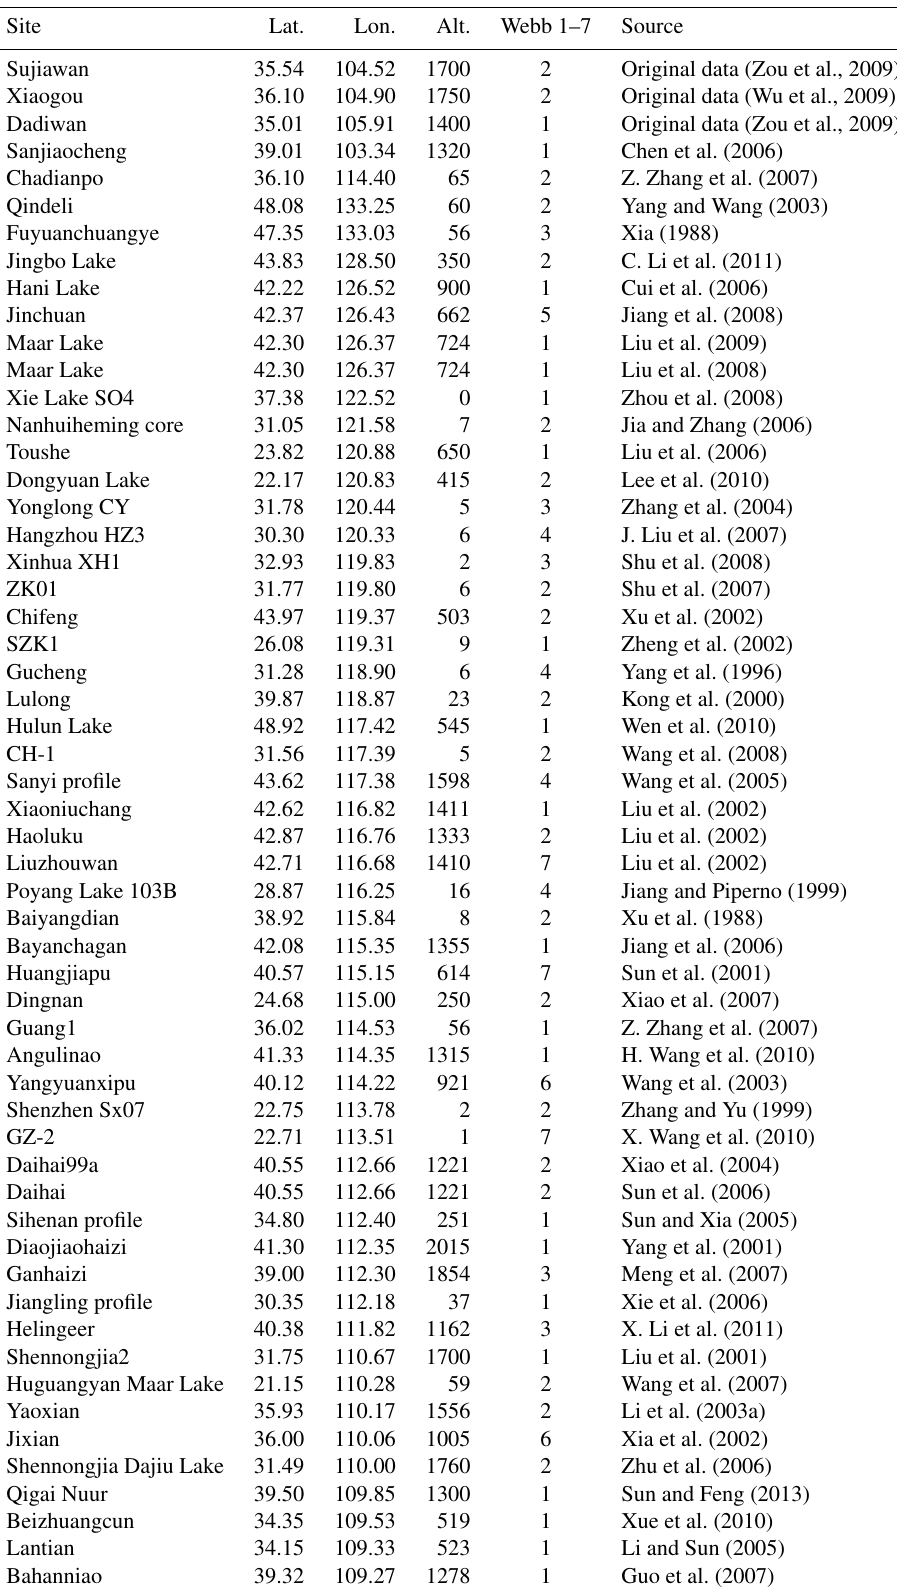
Table 1. Basic information on the pollen dataset used in this study.